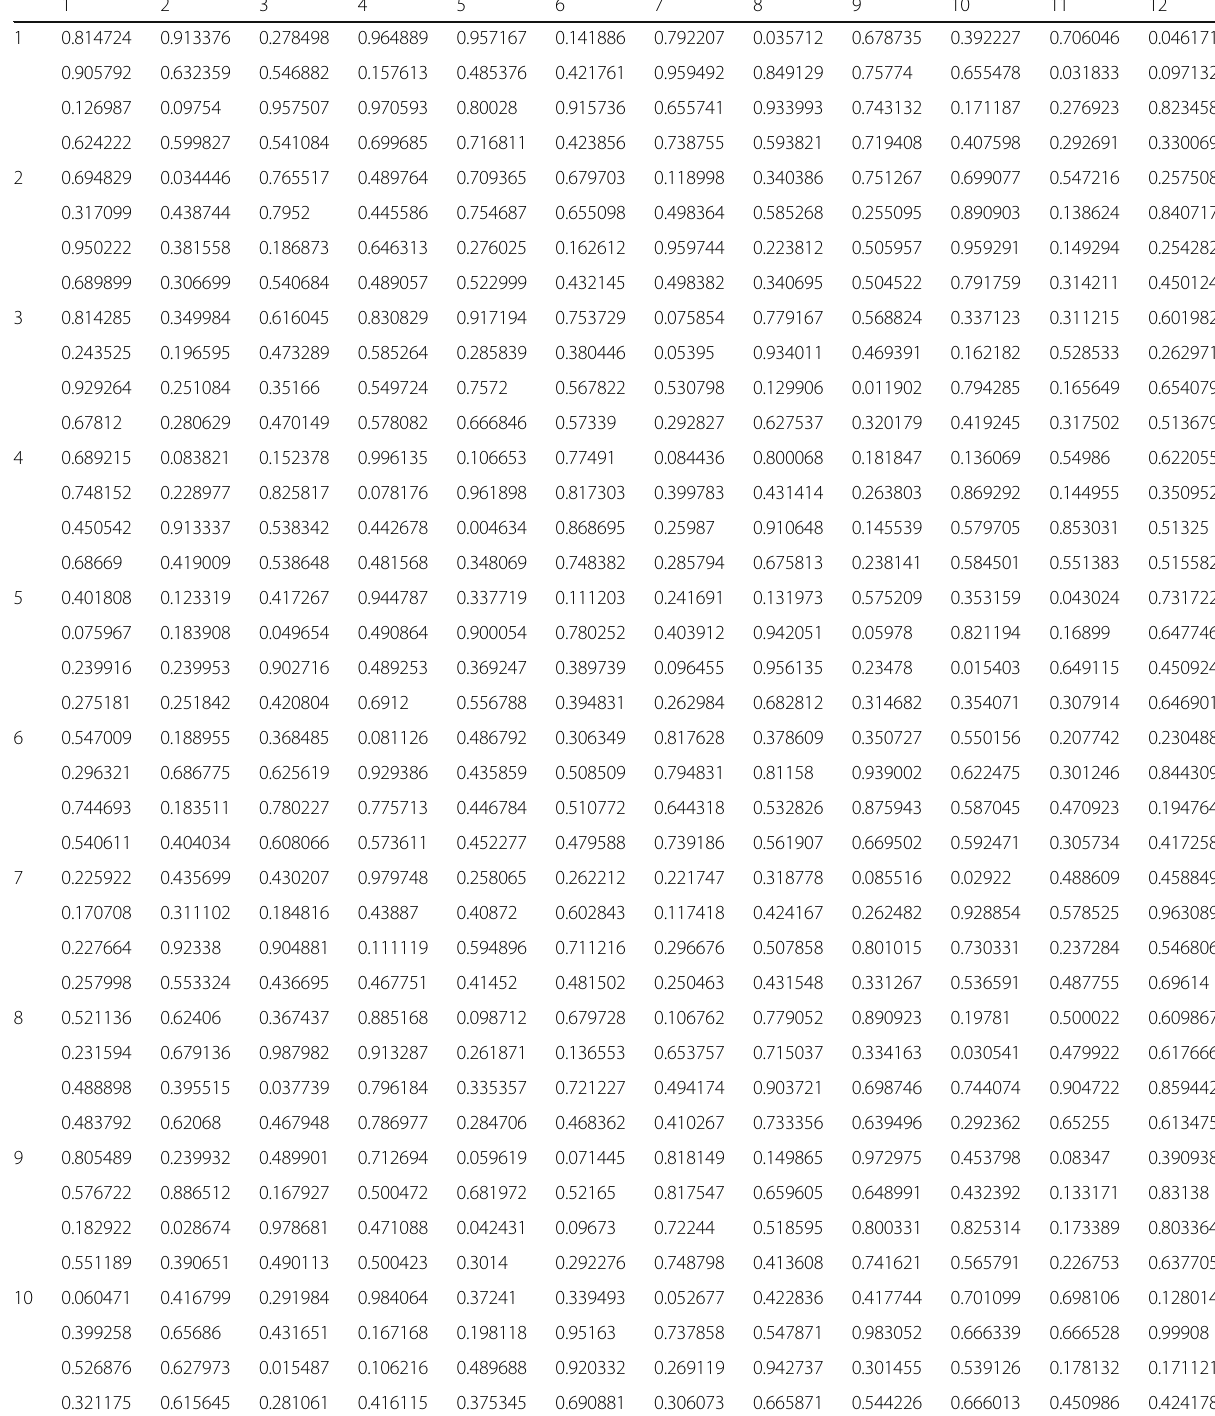
Table 4 users ’ normalized